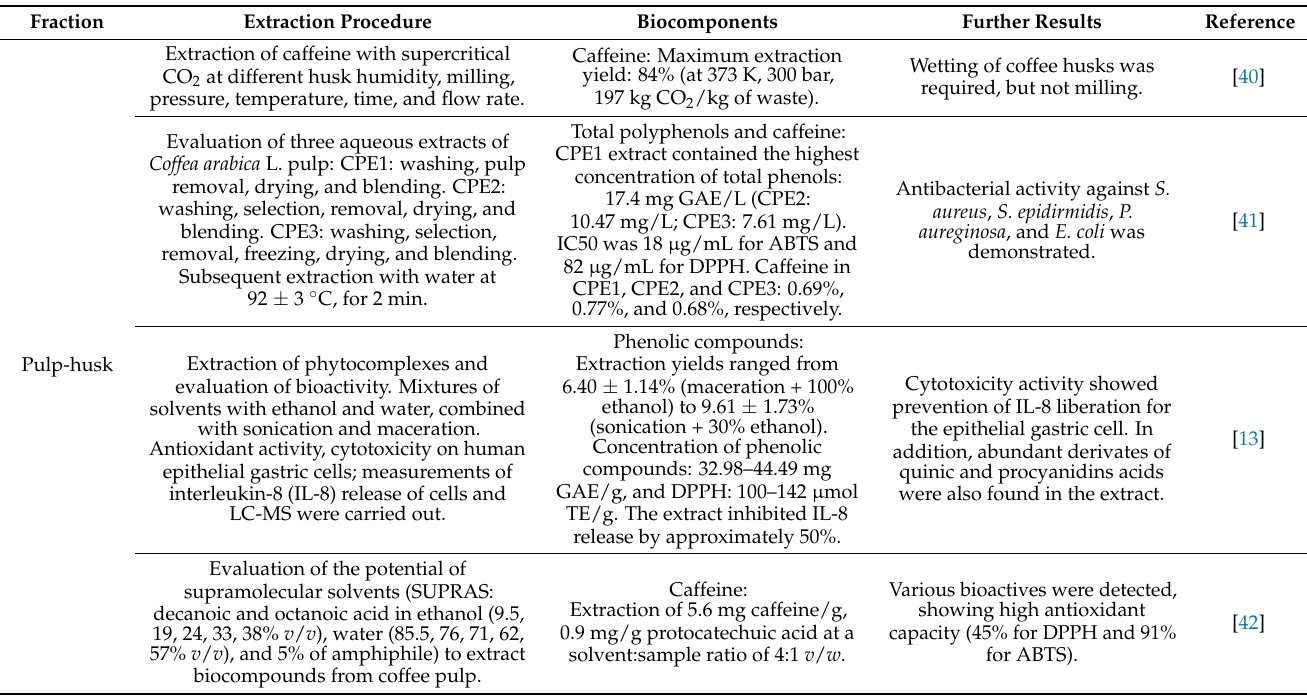
Table 2. Biocomponents obtained from Coffea